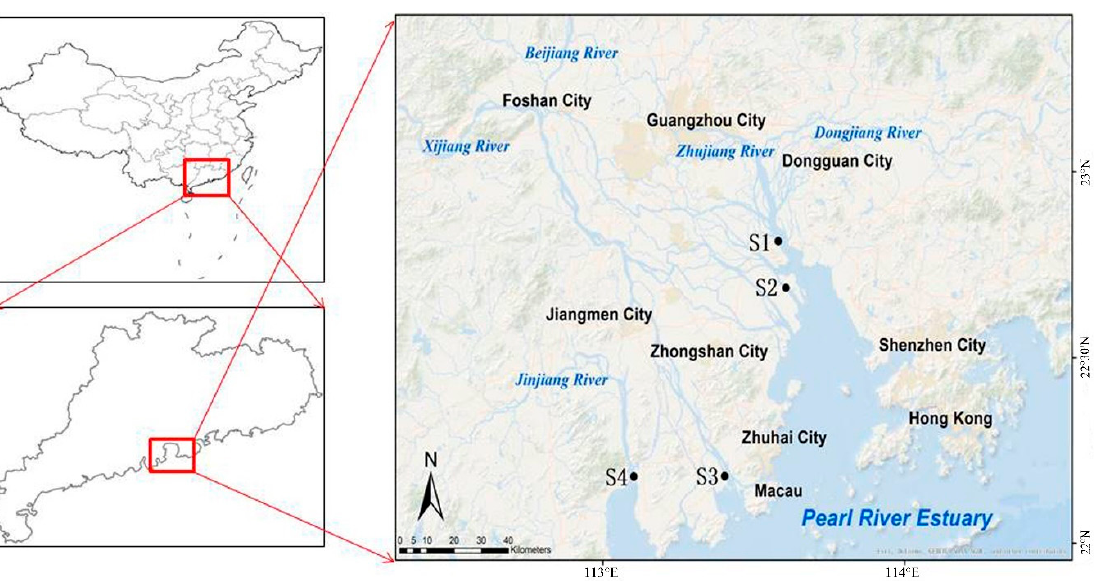
Figure 1. Map of the study areas and sampling sites. S1 was located in the Humen outlet (22°48.851 ′ N, 113°34.829 ′ E), S2 was located in the Jiaomen outlet (22°41.262 ′ N, 113°36.338 ′ E), S3 was located in the Modaomen outlet (22°10.927 ′ N, 113°24.231 ′ E), and S4 was located in the Yamen outlet (22°41.262 ′ N, 113°36.338 ′ E). The base map (sharing scope: all users, powered by Esri) was obtained in ArcGIS Online and edited by ArcGIS 10.2 (the URL for the base map: http://server.arcgisonline.com/arcgis/rest/services/Ocean/World_Ocean_Base/MapServer).